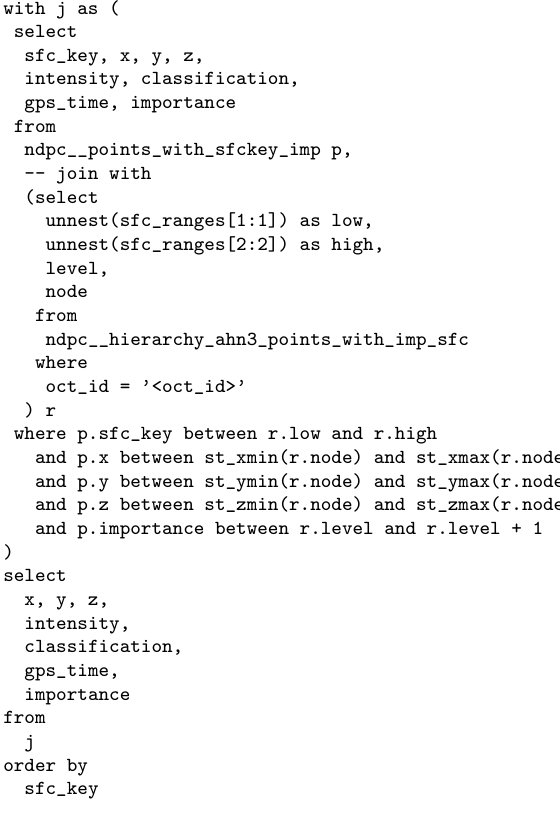
Figure 5. Querying points associated with one octree node. The unnest function takes care of unpacking the SFC ranges stored as array to two columns (named low and high). The first filter (sfc key between low and high) uses the B-tree index to execute the join, while the second filter filters the points exactly on space and